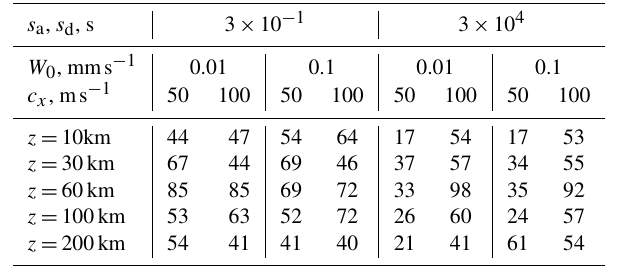
Table 1. AGW decay times τ 0 in hours in the interval t ∼ 170– 290h at different altitudes for various parameters of the surface wave sources (Eq. 5) and their time dependences (Eq. 7).